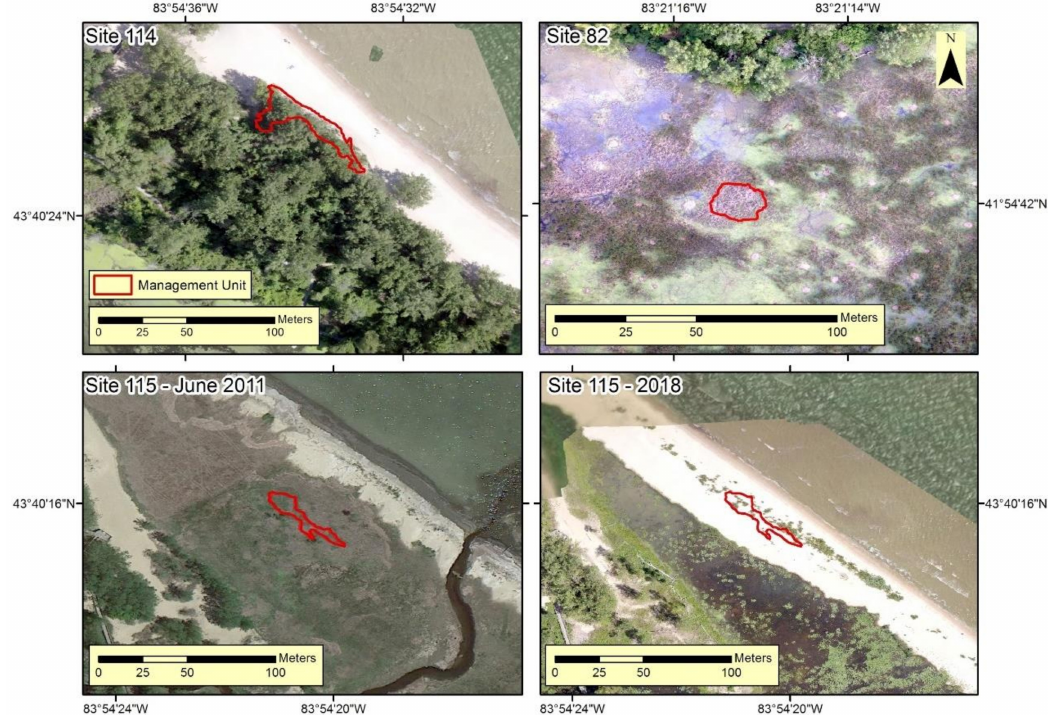
Figure 10. Examples of Phragmites management sites where UAV deployment was not appropriate. Site 114 (top left) was located underneath dense vegetation canopy, site 82 (top right) was extremely small (<0.1 ha), and site 115 (bottom row) suffered an erosional event caused by raising water levels that resulted in the removal of Phragmites present. Pretreatment areas in 2011 as viewable in Google Earth (bottom left) are eroded away in 2018 UAV imagery collected for this project (bottom